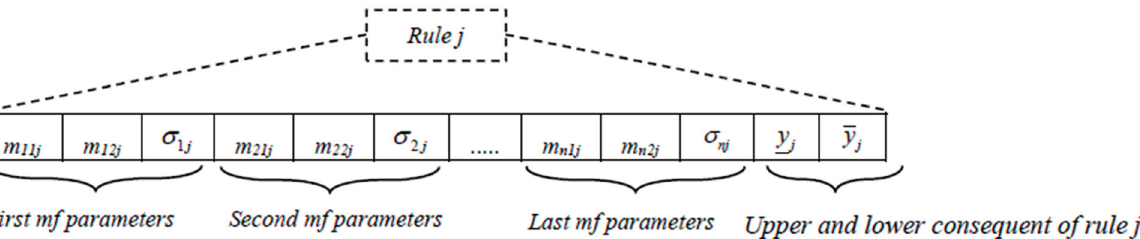
Figure 6. Scheme coding of a sub-solution in the proposed T2 FLS